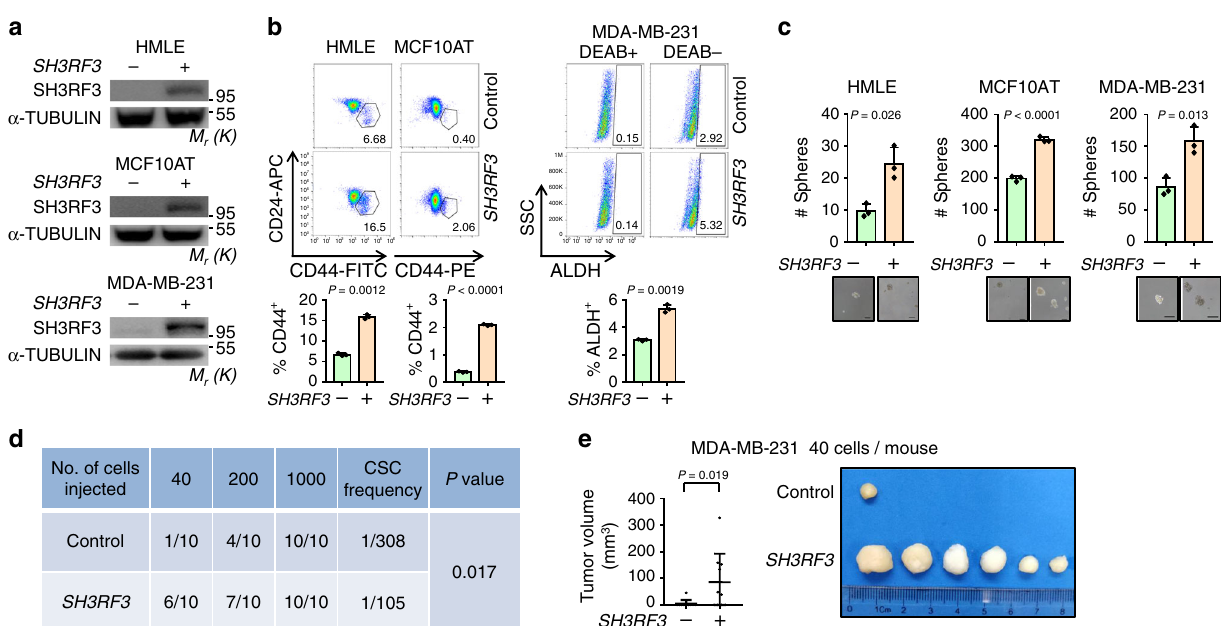
Fig. 2 SH3RF3 promotes CSC properties of breast cancer cells. a SH3RF3 overexpression in HMLE, MCF10AT and MDA-MB-231 cells. b Flow cytometry analyses of the CD44 + CD24 − subpopulations in HMLE and MCF10AT, and the ALDH + subpopulation in MDA-MB-231. Numbers in the fl ow cytometry charts indicate the CSC percentages ( n = 3 culturing experiments). c Quantitation and representative images of tumorsphere formation in SH3RF3 - overexpressing breast cancer cells ( n = 3 culturing experiments). Scale bar,100 μ m. d In vivo tumor formation of the mice injected with serial dilutions of MDA-MB-231 cells at day 28. e Tumor images and volumes ( n = 10 mice) in mice injected with 40 control and SH3RF3 -overexpressing MDA-MB-231 cells. Data represent mean ± SD. Statistical signi fi cance was determined by two-tailed unpaired t -test ( b and c ), chi-squared test ( d ) or Mann – Whitney U-test ( e ). The experiments in ( a ), ( b ) (upper), and ( c ) were repeated three times independently with similar results, and the data of one representative experiment are shown. Source data are provided as a Source data fi breast cancer cell lines (Fig. 4c), further con fi rming that PTX3 is a downstream gene regulated by SH3RF3 .